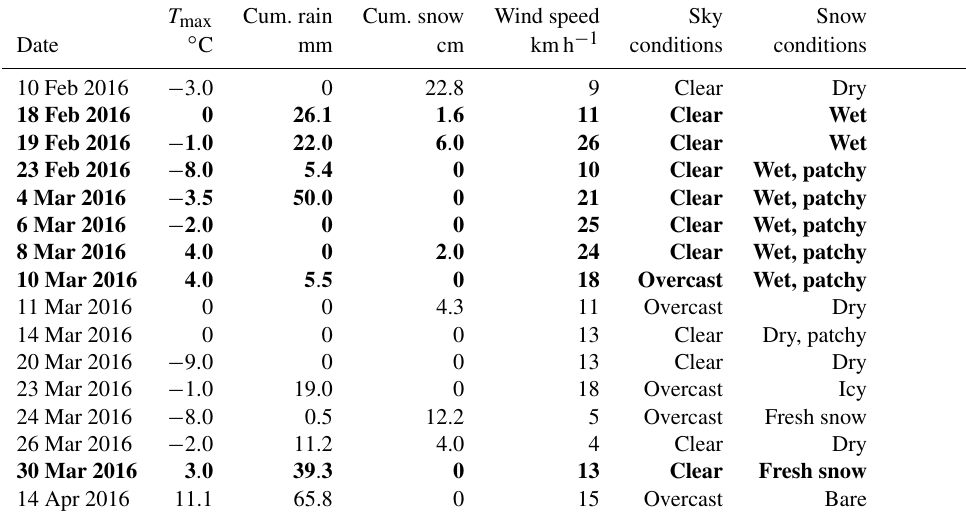
Table 3. Environmental conditions during P3P missions over Acadia. Rain and snow correspond to cumulated totals since the previous mission. Melt periods are in bold font. T max Cum.